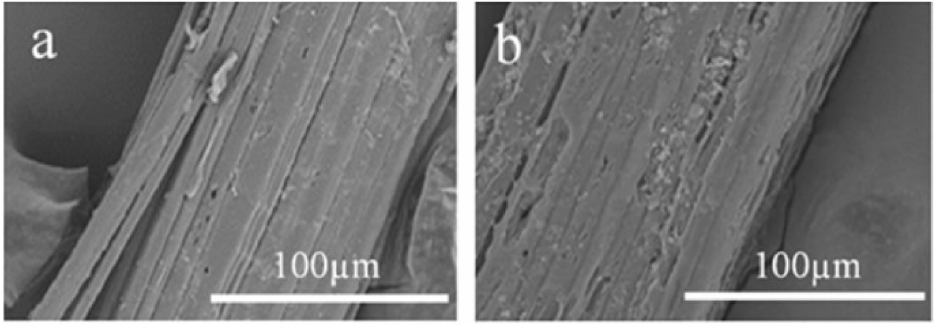
Figure 16. SEM images of alkali-treated jute fiber: ( a ) raw, ( b ) treated